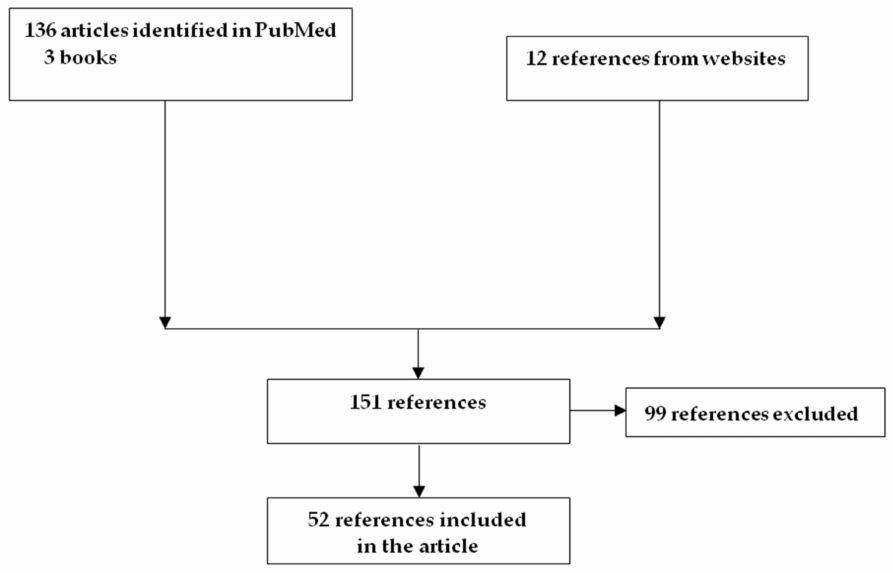
Figure 1. Flow diagram results of literature